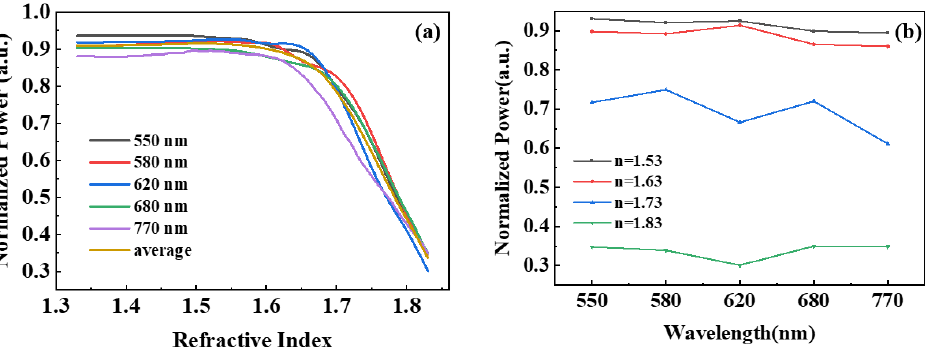
Figure 10. The dependence of the normalized output power of the OW on ( a ) the refractive index of detected material and ( b ) the wavelength of